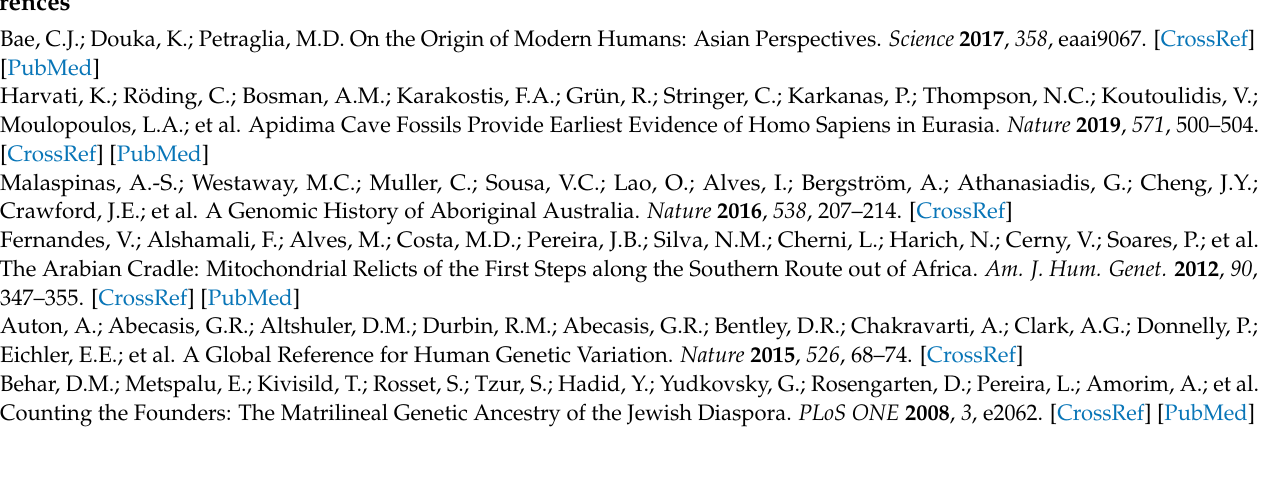
Supplementary Table S3: Samples used for phylogenetic analyses of the N1 haplogroup. Supple- mentary Table S4: The results of intrapopulation analyzes. Supplementary Table S5: Analyses of molecular variance (AMOVA). Supplementary Table S6: Matrix of coancestry coefficients colored according to genetic distance between populations in green < 0.09; yellow < 0.19; red > 0.2. Sup- plementary Table S7: Estimation of population size parameters scaled to mutation rate based on coalescent Bayesian approach Migrate-n. Supplementary Table S8: Estimation of immigration rate (A) and calculation of the relative number of immigrants (B) based on the results of coalescent Bayesian approach Migrate-n. Supplementary Table S9: Age estimates and standard deviations (in years) for the TMRCA of all N1a haplogroups analyzed. Supplementary Figure S1: The derived clade I of mtDNA haplogroup